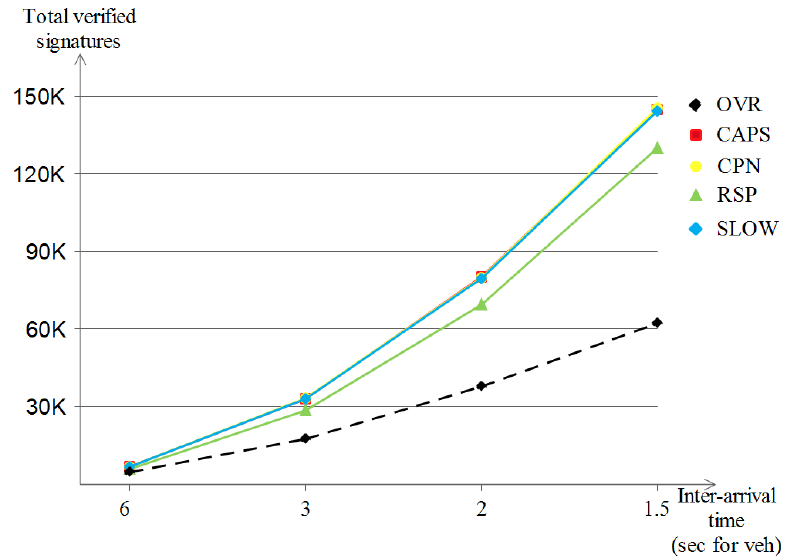
Figure 22. Verified signatures number of privacy schemes in the highway